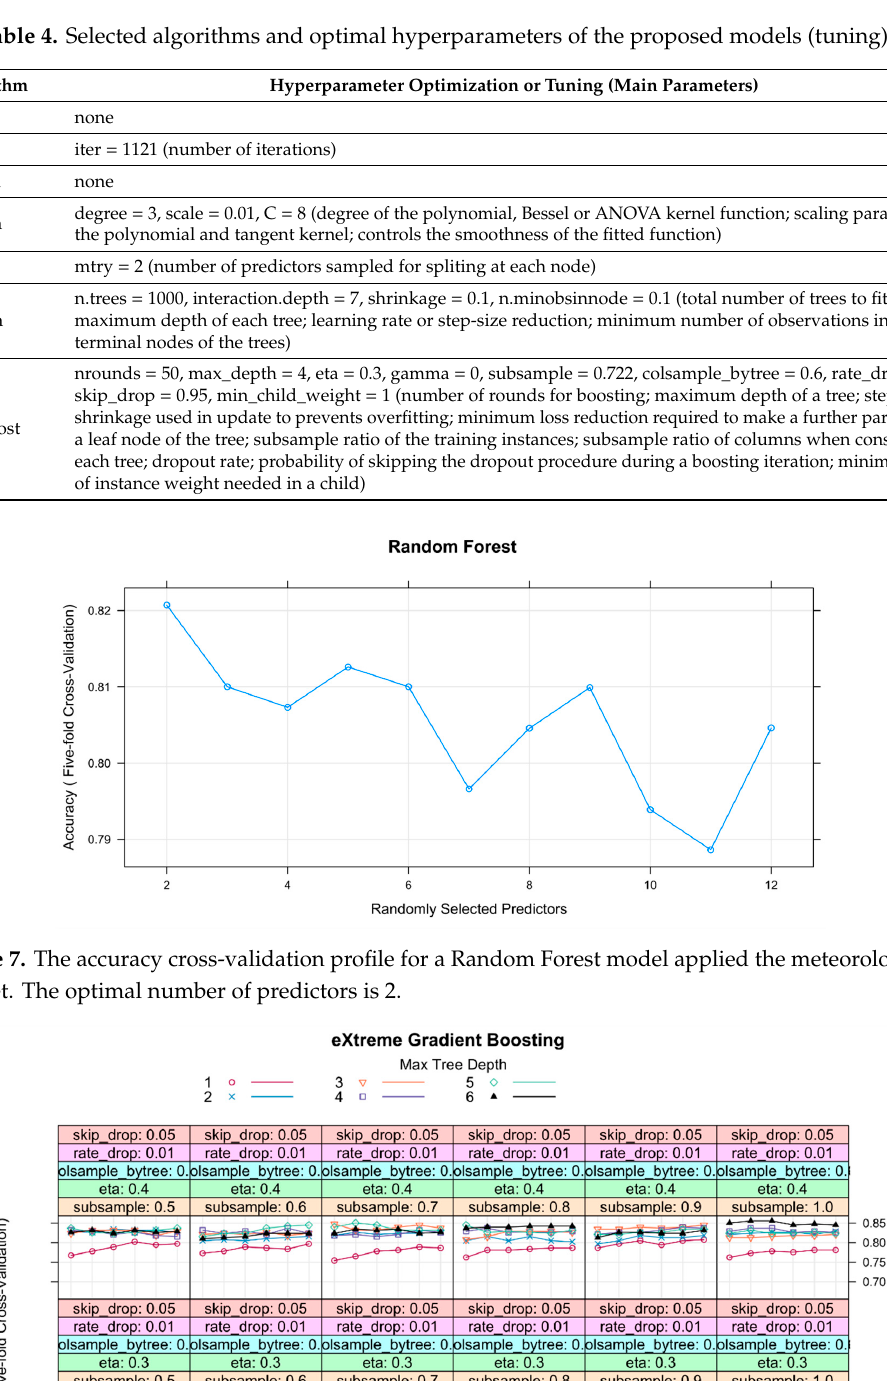
Figure 9. The cross-validation profiles for a Stochastic Gradient Boosting model applied to the Tenerife meteorological data [2]. The final model was fit using the hyperparameters shown in Table 4. 4. Discussion In this section, the results obtained in the experiments are shown and discussed. XGBoost and gbm models are the ones providing highest overall accuracy followed closely by rf. Friedman test was performed to determine whether the differences in accuracy were significant. For a significance level α = 0.05 in the Friedman test ( p -value = 0.01), evidence was found that the seven classifiers achieve the same accuracy and therefore H 0 was rejected. Box and Whisker Plots allow us to observe the spread of the estimated accuracies for different methods and how they are related to each other. The boxes are ordered from highest to lowest mean accuracy. The evaluation metrics are accuracy and kappa because they are easy to interpret. The algorithms were chosen for their diversity of representation and learning style (Figure 10).